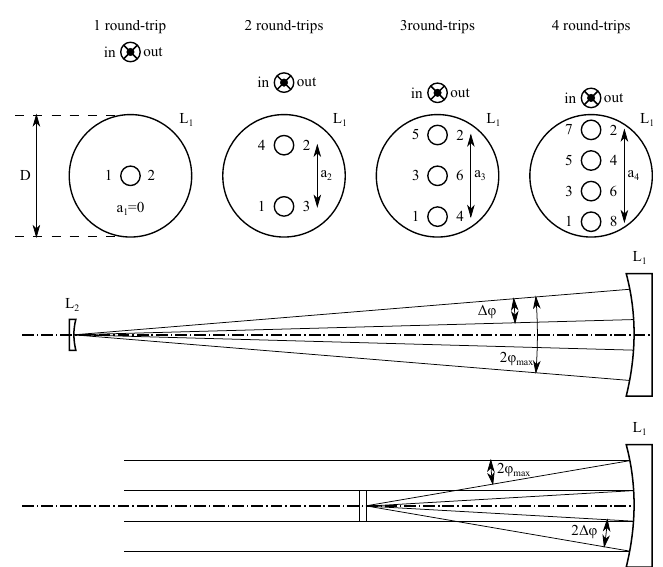
Figure 7. Upper image: arrangement of passes on optic L 1 for different numbers of round-trips. The numbers denote the sequence of hits on the optic L 2 . Center image: parameters for folding angles on L 2 due to the round-trips in a Type II system with four round-trips. Lower image: parameters for folding angles on L 1 due to the round-trips in a Type I system with four